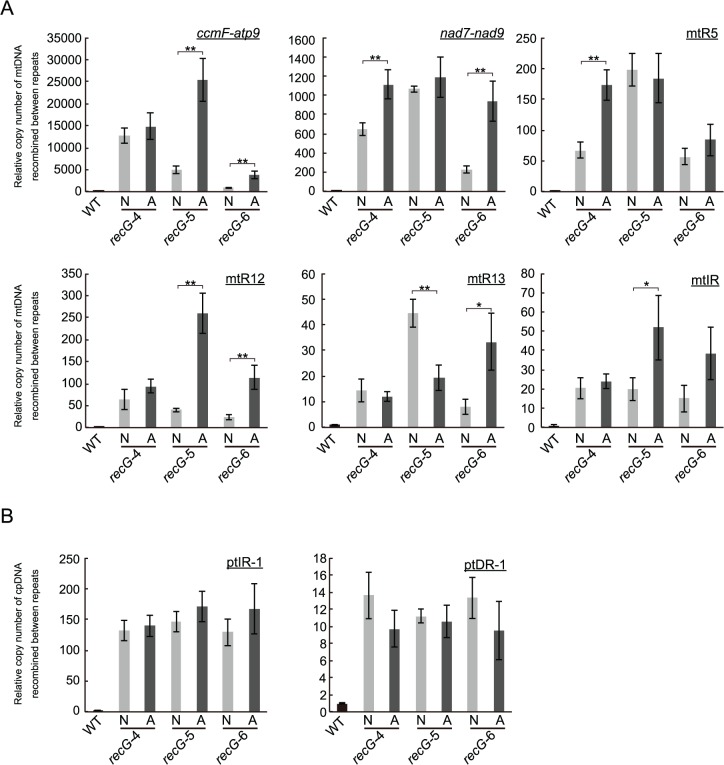
Status of organelle DNA in recG-N and recG-A cells.Relative copy number of DNA resulting from recombination between mitochondrial short repeats (ccmF-atp9, nad7-nad9, mtR5, mtR12, mtR13, and mtIR; A) per mitochondrial rpl2 and plastidic short repeats (ptIR-1 and ptDR-1; B) per plastid ndhH in cells mainly comoposed of recG-N or recG-A cells were measured by qPCR using three independent RECG KO lines. WT was given a value of 1. The data represent mean of three replicates ± SD. *p<0.05, **p<0.01.